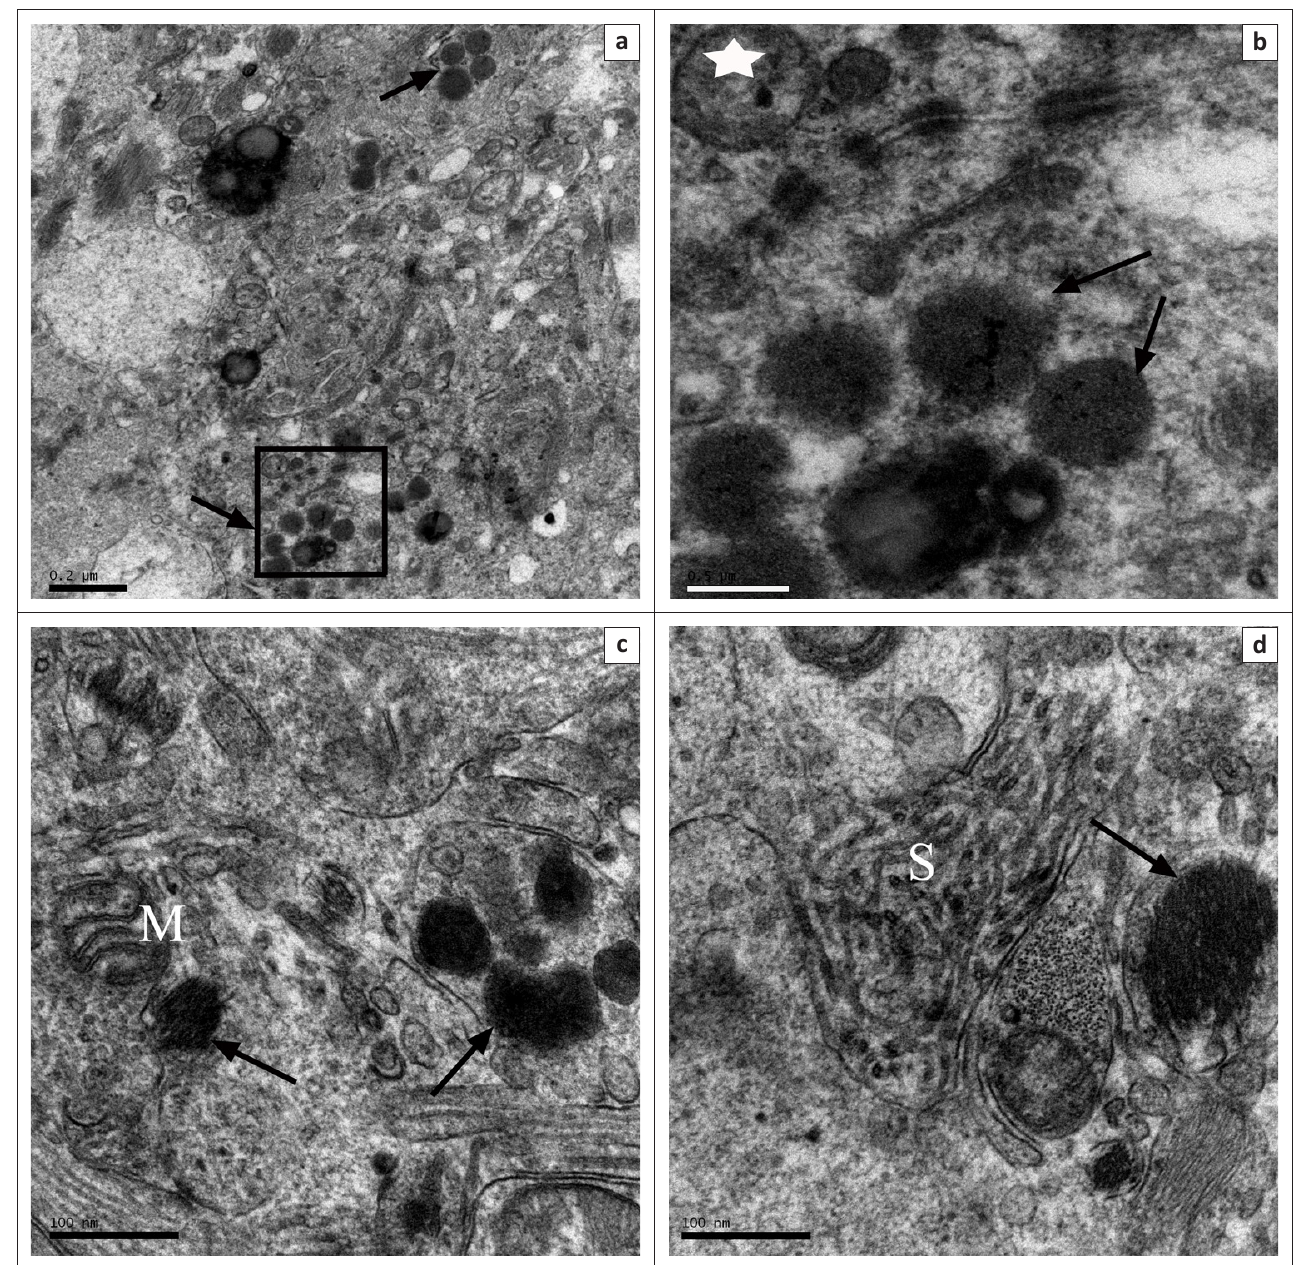
FIGURE 1: Nucleolus-like bodies in the pineal gland of adult yaks (a) an ultrathin section illustrating several NLBs in the parenchyma cells, (b) Higher magnification of the area delineated in the larger NLBs consist of electron-dense granules without surrounding membrane, (c) several NLBs in the pinealocytes (arrows) and (d) NLBs in the terminal of the